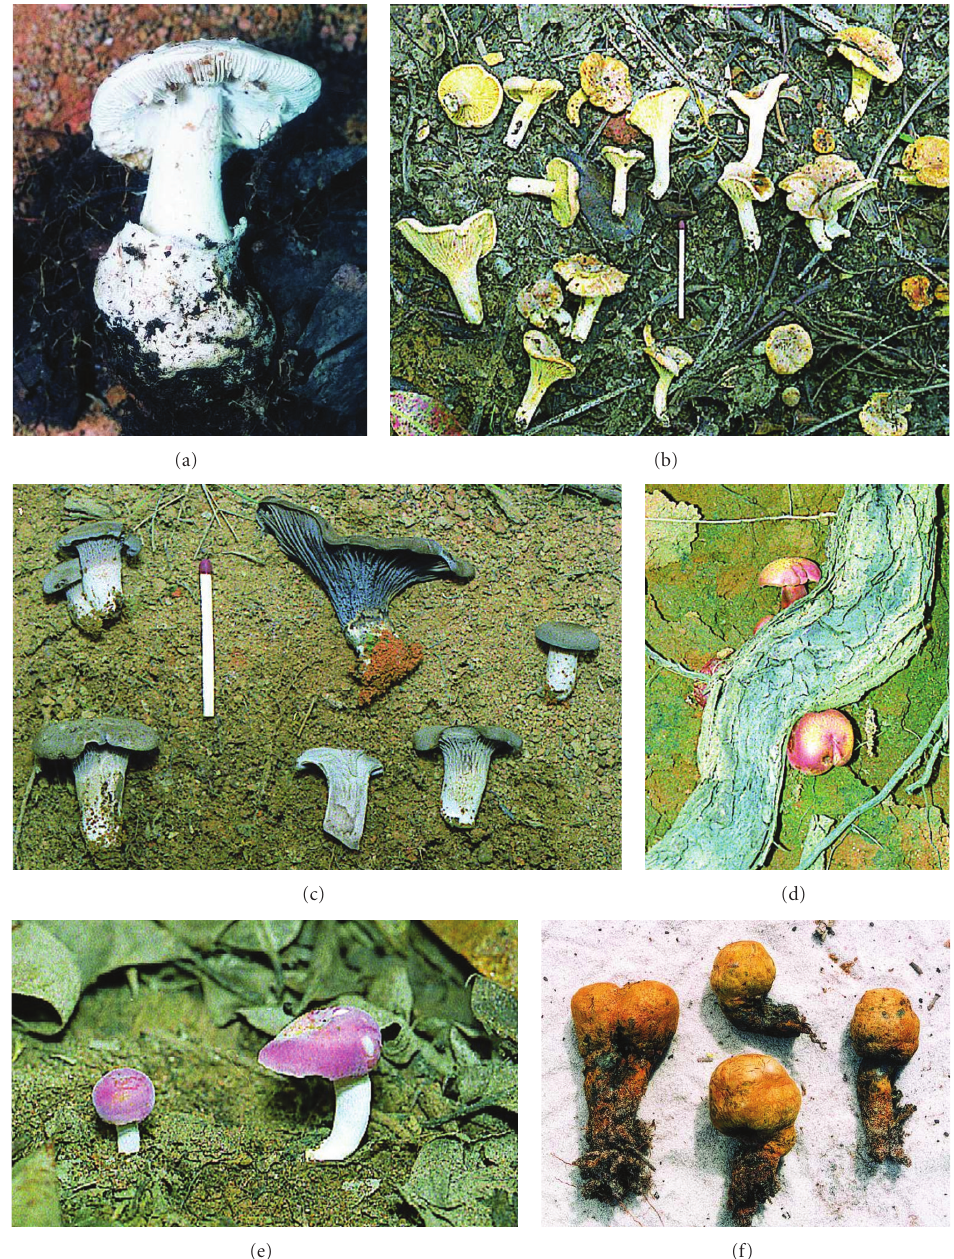
Figure 2: Example of putative ectomycorrhizal fungi of Eucalyptus robusta in Madagascar. (a) Amanita sp.3; (b) Cantharellus eucalyptorum ; (c) Cantharellus congolensis ; (d) Rubinoboletus sp.; (e) Russula sp.3; (f) Pisolithus